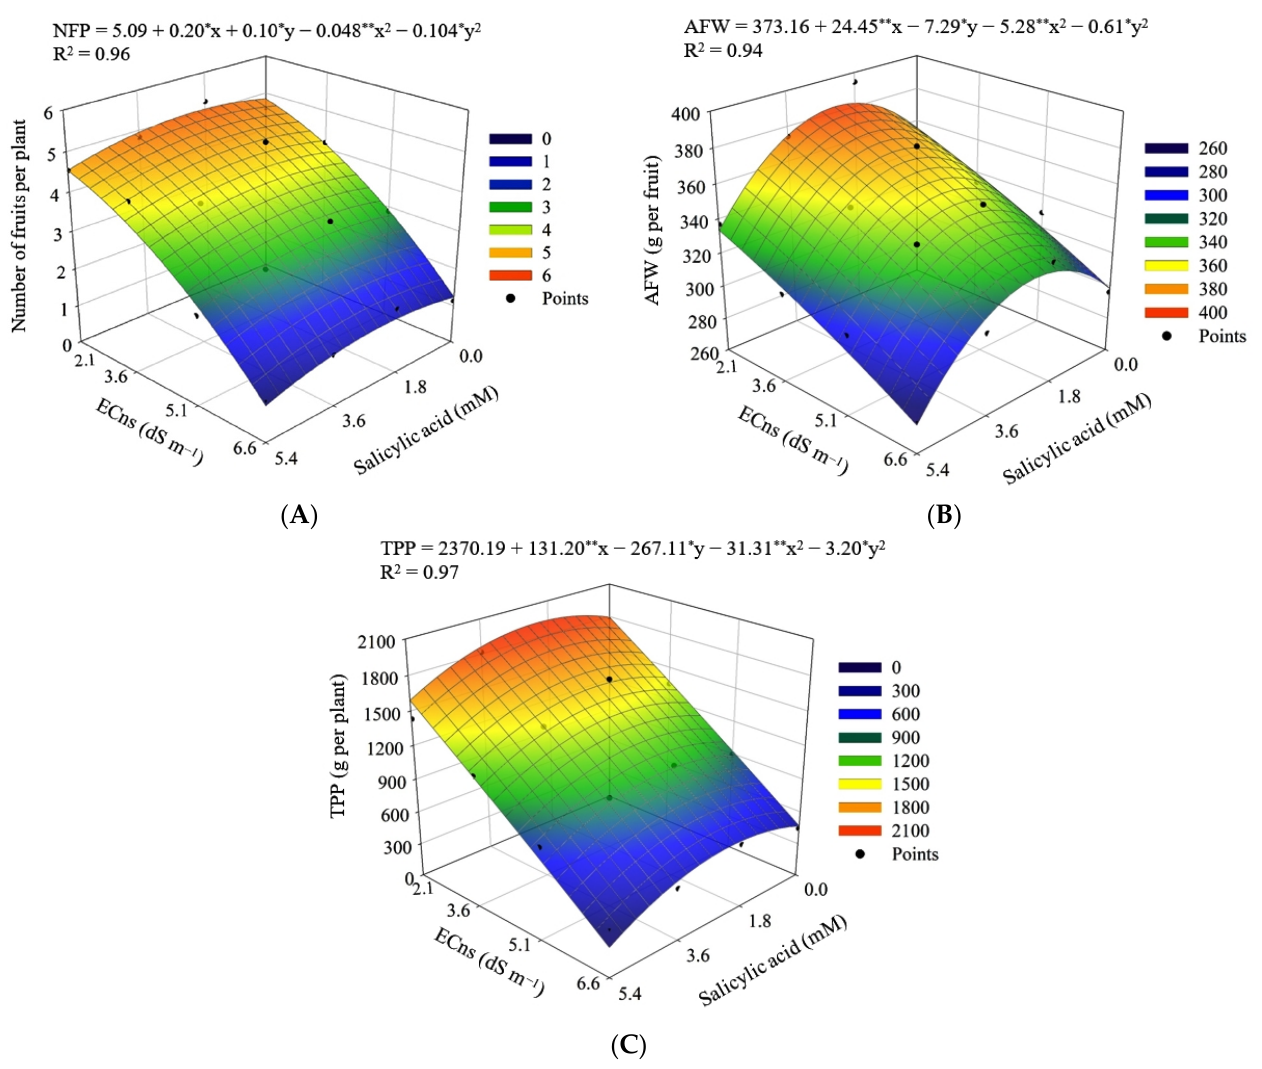
Figure 9. Response surface for the number of fruits per plant—NFP ( A ), average fruit weight—AFW ( B ), and total production per plant—TPP ( C ) of Japanese cucumber as a function of the interaction between the electrical conductivity of the nutrient solution (ECns) and the concentrations of salicylic acid (SA), grown in a hydroponic system, 45 days after transplanting. X and Y—concentration of SA and ECns, respectively; * and ** significant at a p ≤ 0.05 and p ≤ 0.01,